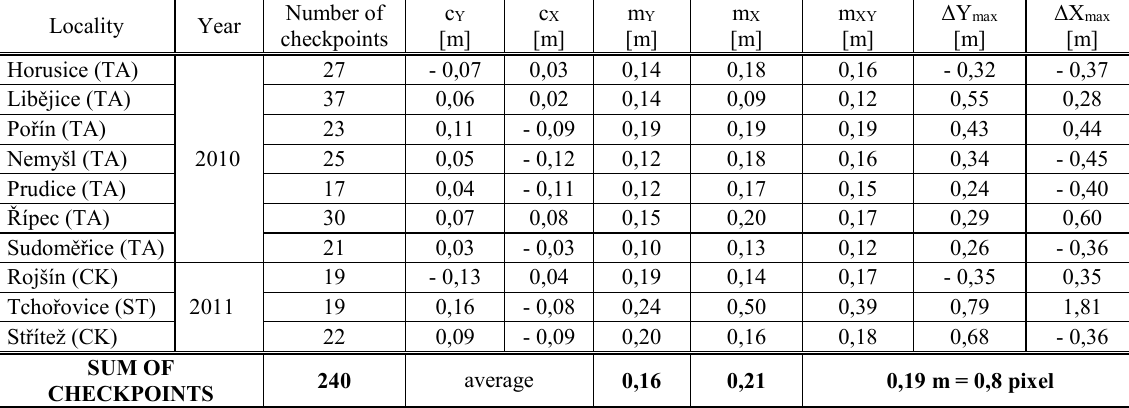
Table 3. Absolute positional accuracy verification of the Orthophoto of the CR with pixel dimensions of 0.25 meters in selected